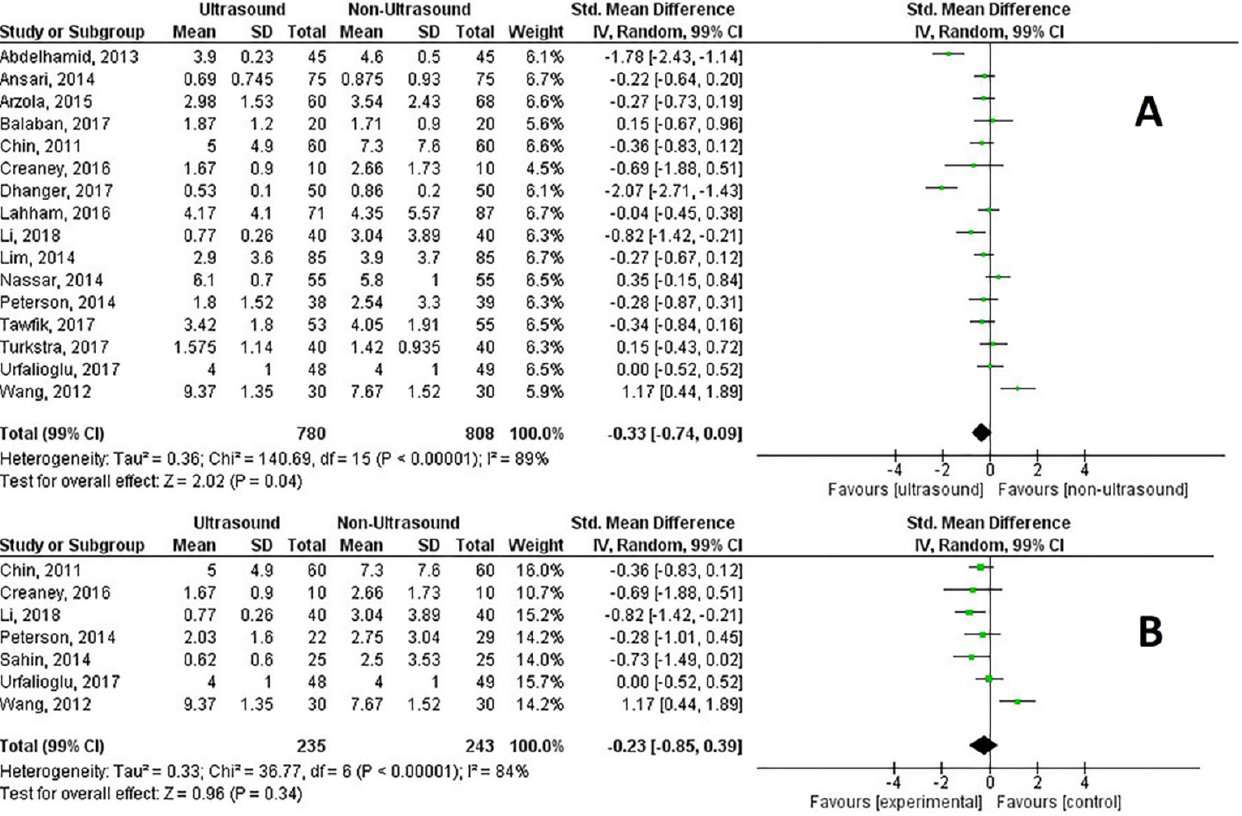
Figure 5. ( A ) Number of needle redirections of neuraxial procedures; ( B ) Number of needle redirections in difficult spines and obese patients.